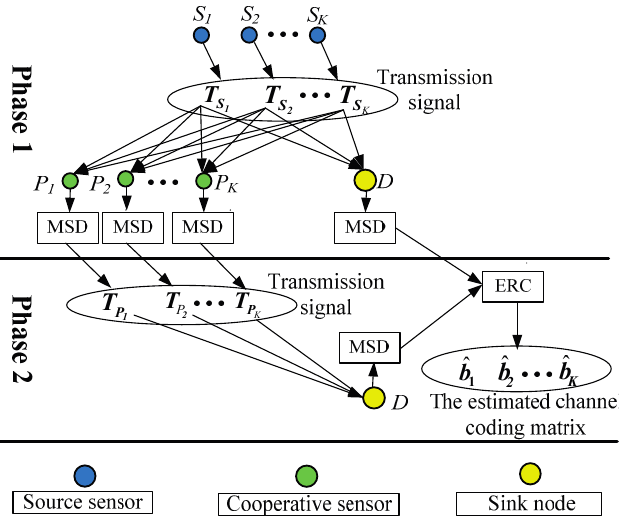
Figure 3. The block diagram of signal transmission in two phases: t = 1: Phase 1; t = 2: Phase